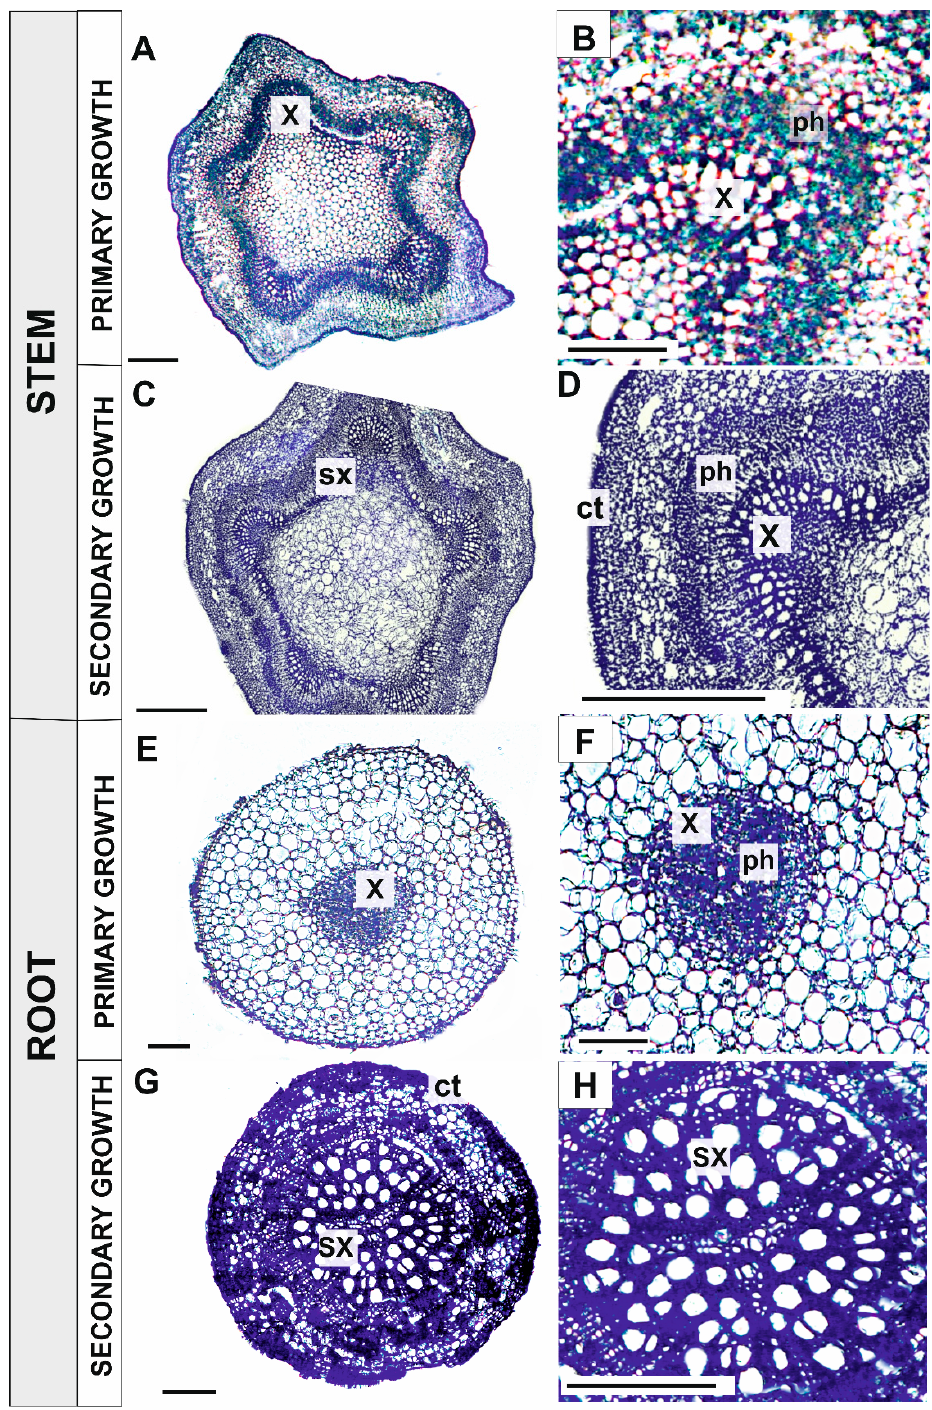
Figure 3. Localization of superoxide (dark blue dye) in stems of black cottonwood ( Populus trichocarpa ) with primary ( A,B ) and at the beginning of secondary growth ( C,D ), as well as in pioneer roots with primary growth ( E,F ) and secondary growth ( G,H ). (Abbreviations: x—primary xylem, sx—secondary xylem, ph—phloem, pf—phloem fibres, ct—cork (phellem)). Bars = 100 µ